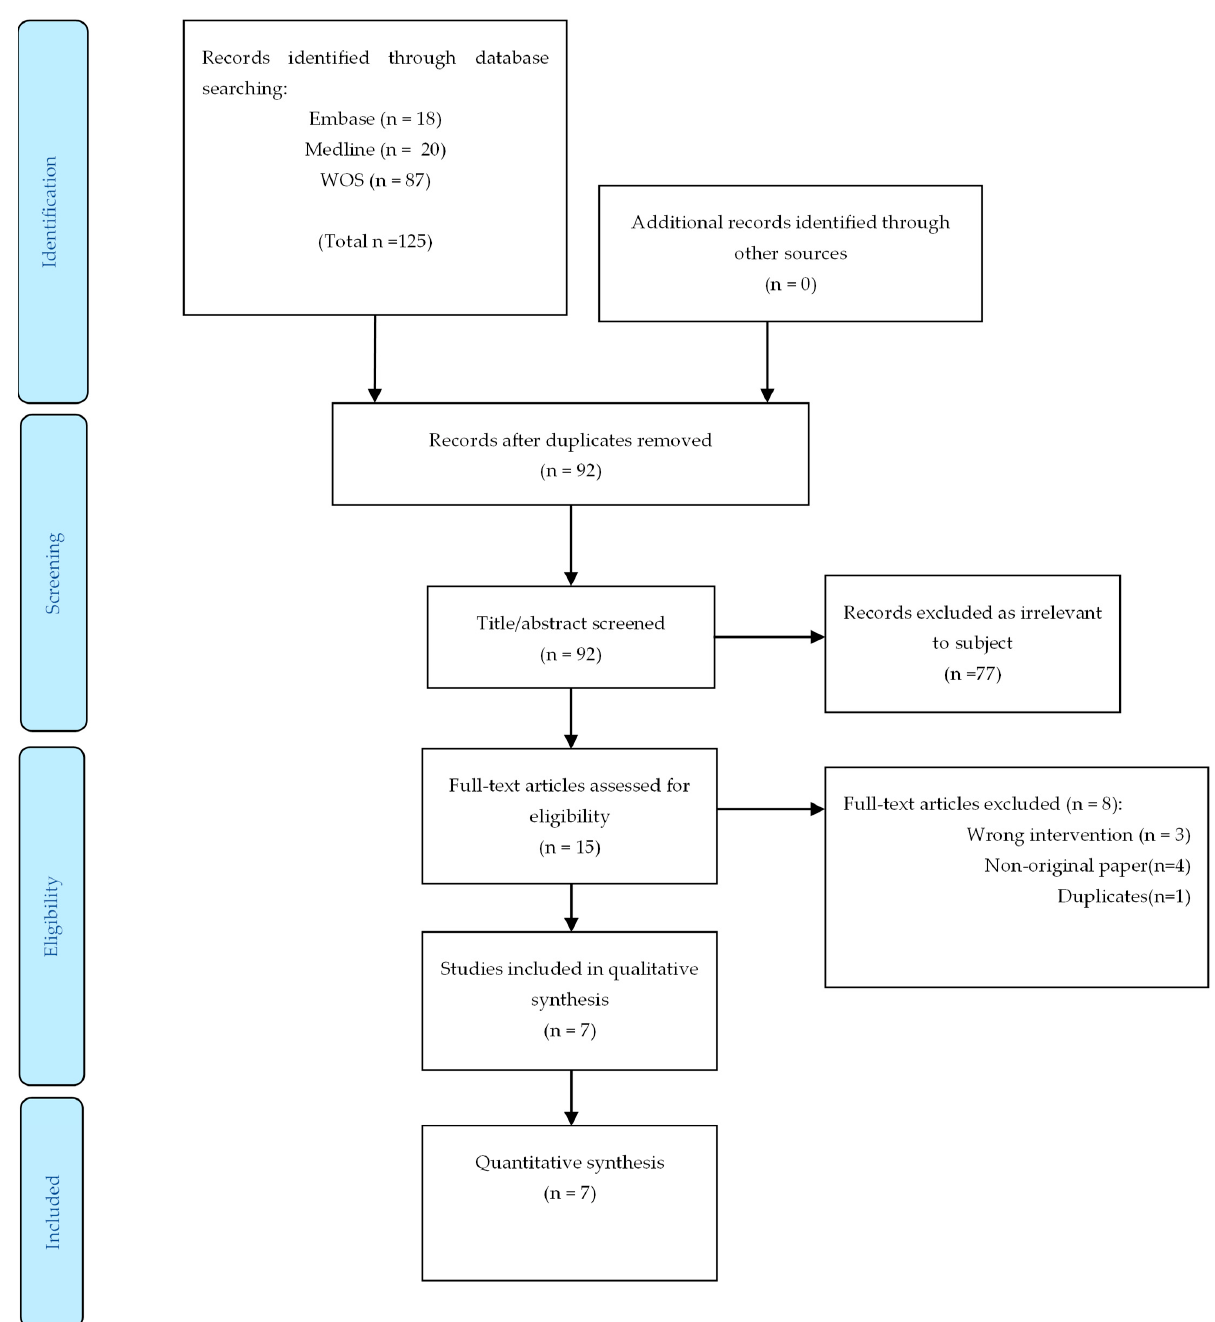
Figure 1. Flow diagram of retrieval of studies from the literature review. WOS, Web of